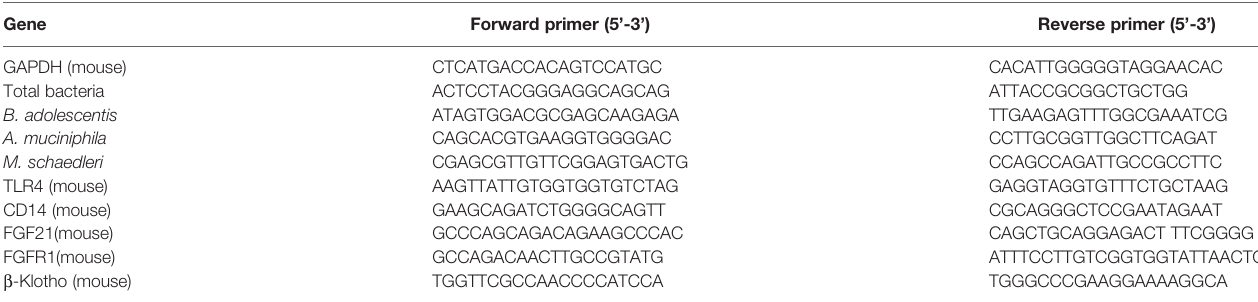
TABLE 1 | Primers for